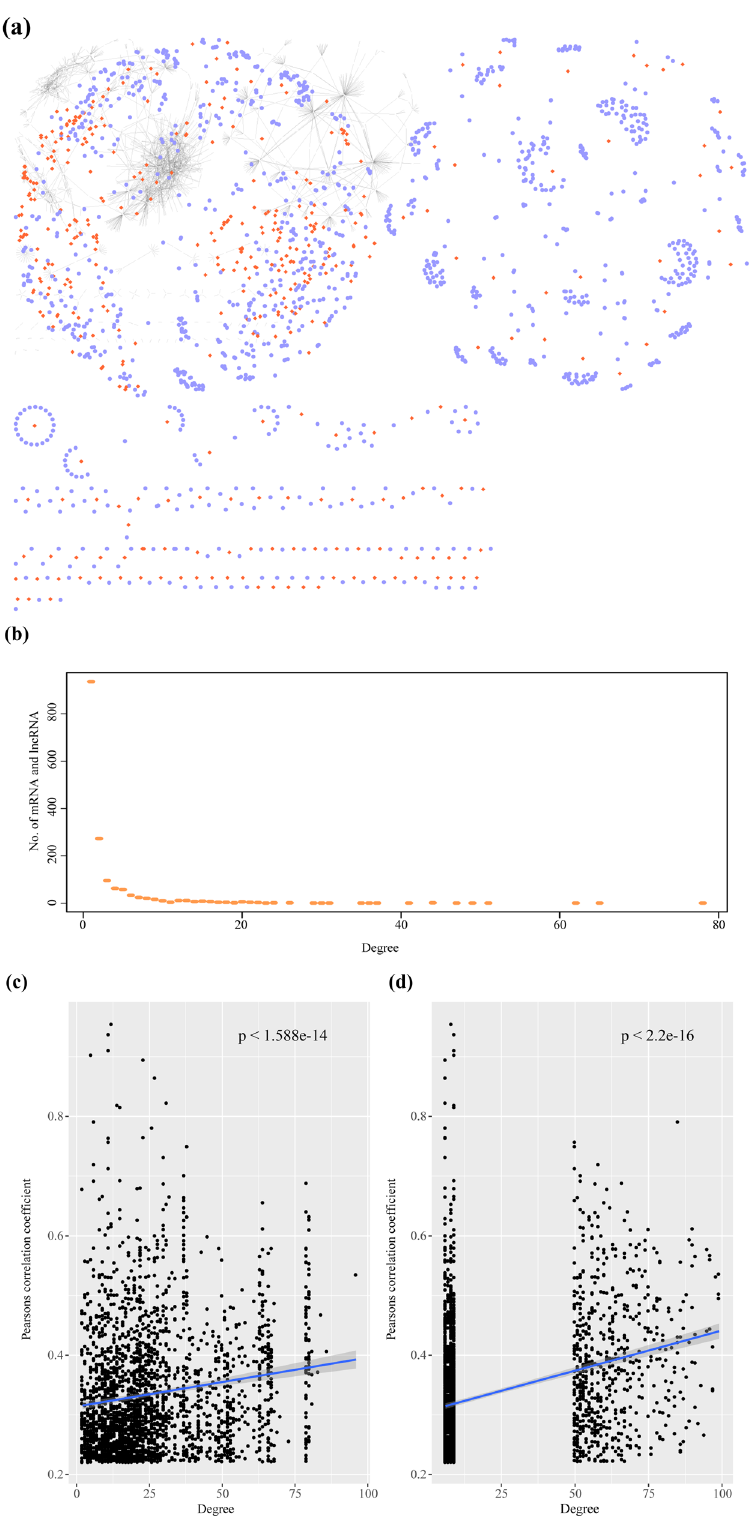
Figure 2: Constructing HCC - speci fi c ceRNA network and mRNA – lncRNA coexpression characteristics: ( a ) ceRNA network in the HCC sample. The blue node in the fi gure represents the gene, and the orange - red node represents the lncRNA, ( b ) networks degree distribution of ceRNA in HCC samples, ( c ) correlation between the network degree of ceRNA and coexpression of mRNA – lncRNA in HCC samples, and ( d ) correlation between the number of miRNAs shared by mRNA – lncRNA and the coexpression of mRNA – lncRNA in the ceRNA network for HCC